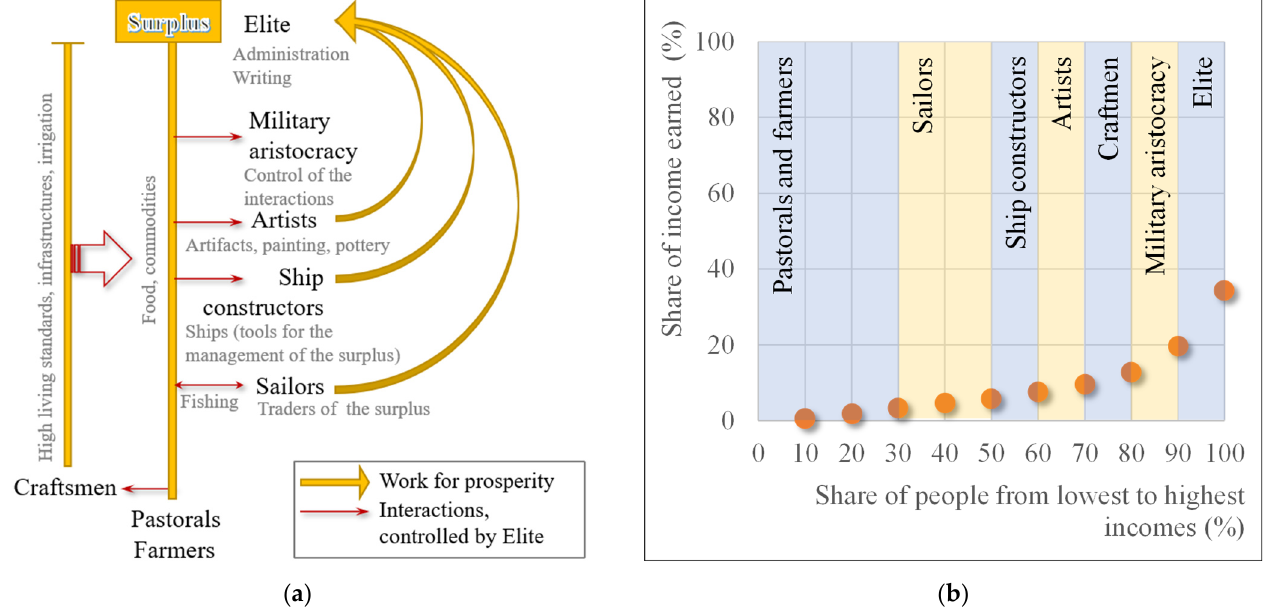
Figure 20. ( a ) Creation of wealth and interactions in Minoan society; ( b ) A hypothetical stratification in Minoan society with Gini coefficient equal to 0.5.